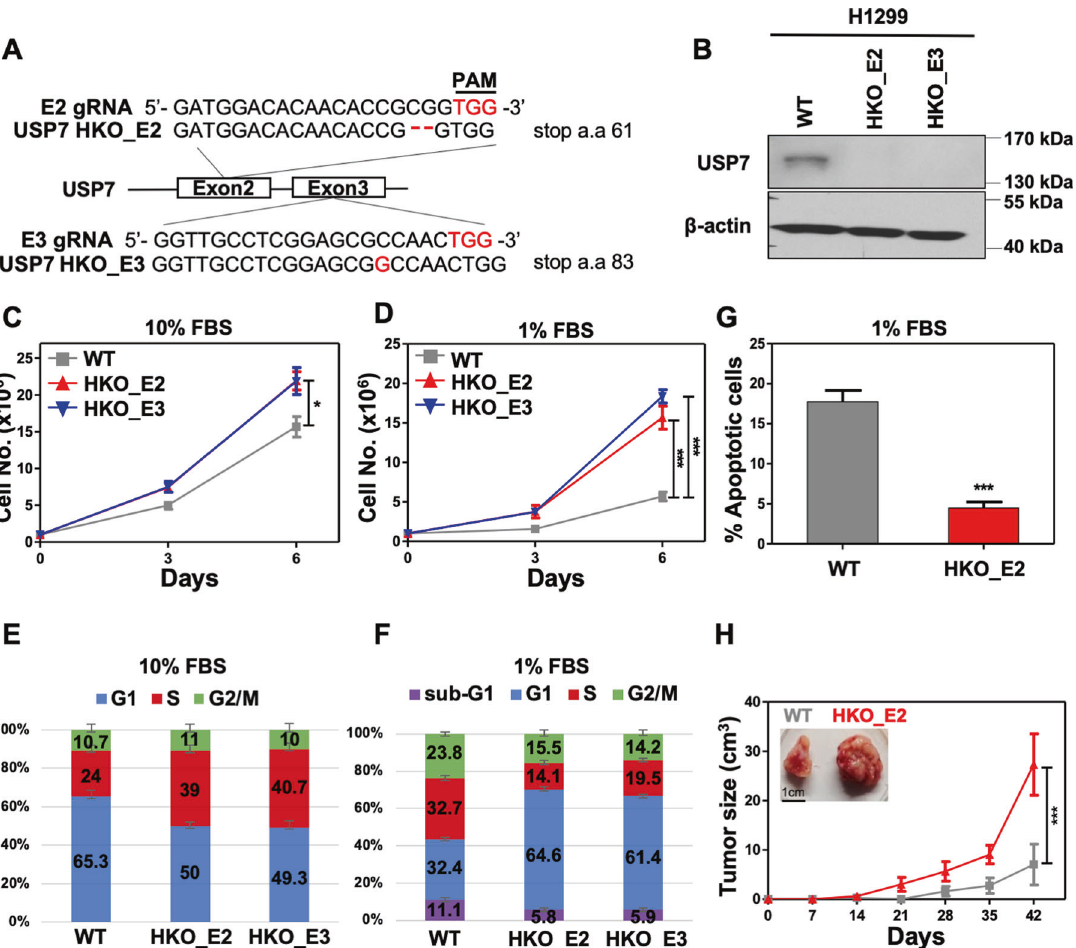
Fig. 1 Inactivation of USP7 promotes cell progression of p53-de fi cient lung cancer H1299 cell line. A Schematic of guide RNA (gRNA) design and genomic sequences of USP7 knockout (KO) clones. KO_E2 Exon 2 targeted, KO_E3 Exon 3 targeted, PAM protospacer adjacent motif. B Immunoblots of USP7 in the lysates from wildtype (WT) or indicated USP7 KO H1299 cells. β -actin is the loading control. C – F Cell proliferation ( C , D ) and cell cycle pro fi ling ( E , F ) assays of wildtype (WT) and USP7 KO (HKO_E2 and HKO_E3) H1299 cell lines in culture media supplemented with 10% ( C , E ) or 1% fetal bovine serum (FBS) ( D , F ). Results are mean ± SD from three independent experiments. G Apoptotic cell pro fi ling by Annexin V staining in wildtype (WT) or USP7 KO (HKO_E2) H1299 cells treated with 1% FBS for 6 days. H The growth curves